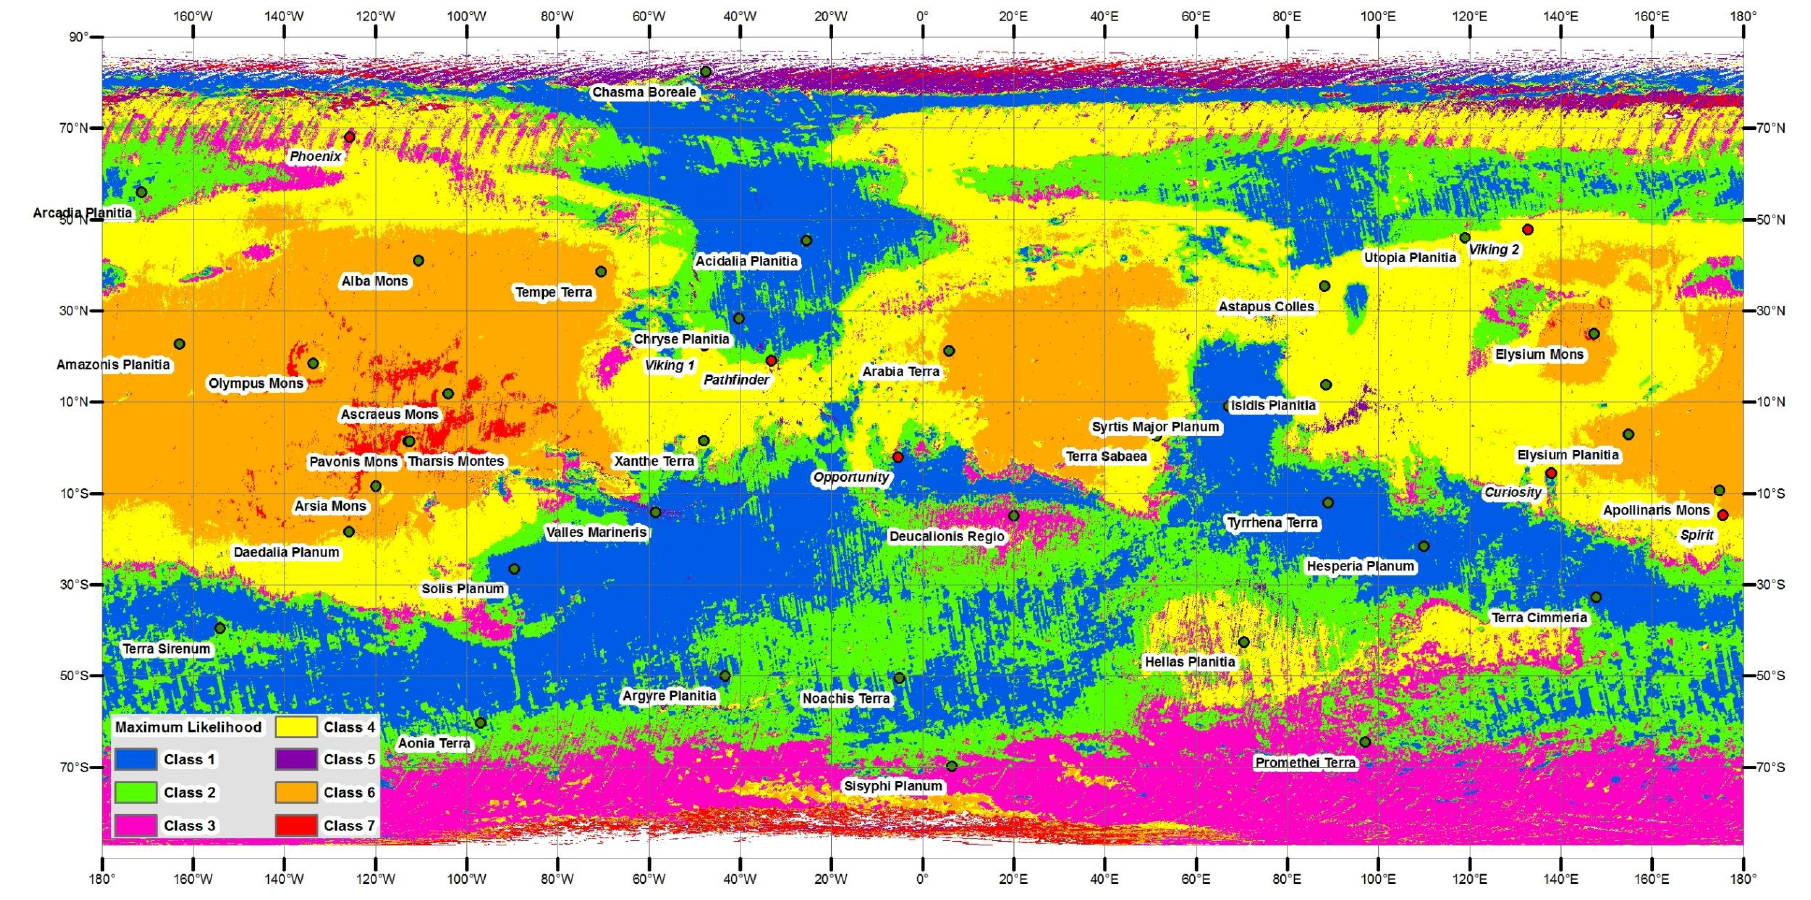
Figure 13. The spatial distribution of seven classes from the combined ISODATA and MAXLIKE classification in Martian thermal inertia and